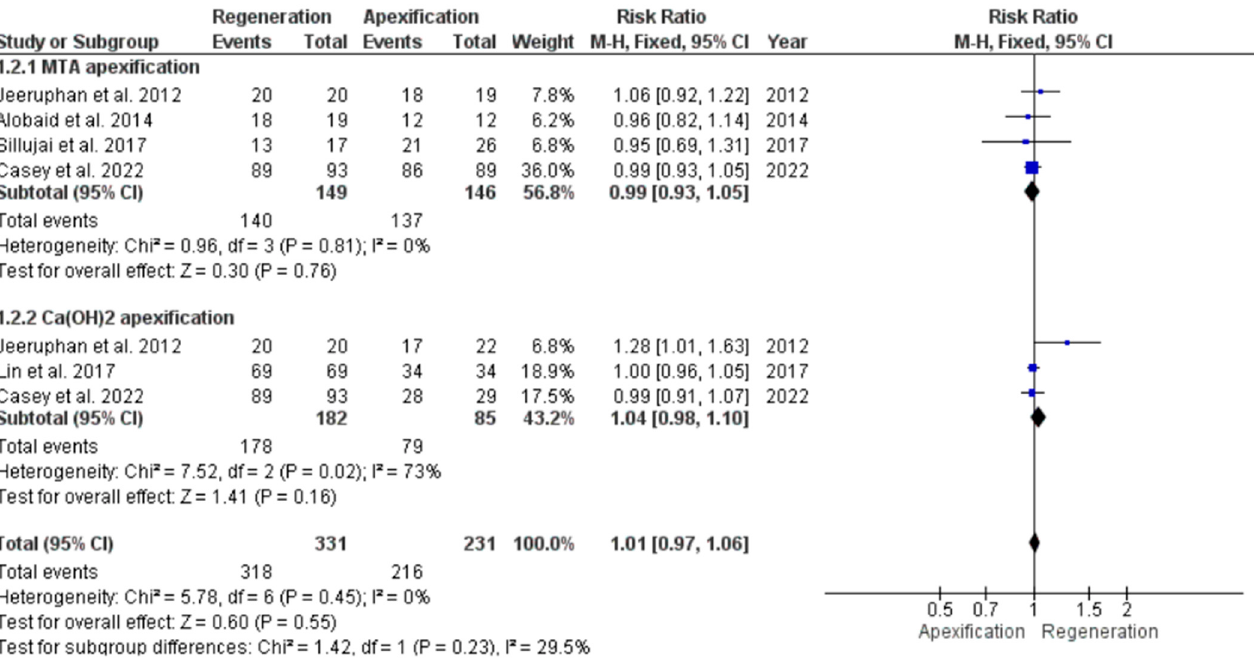
Figure 9. Meta-analysis of survival rate of young immature permanent teeth that underwent regen- erative endodontic procedure (REP) or apexification procedure.